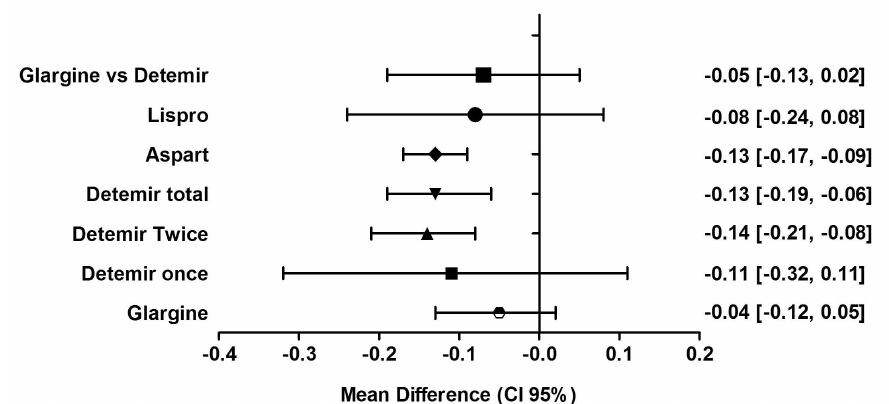
FIGURE 2 - Forest plots showing the MD based on the HbA1c changes at the end of the studies in adults with type 1 diabetes using the inverse variance method (random effect